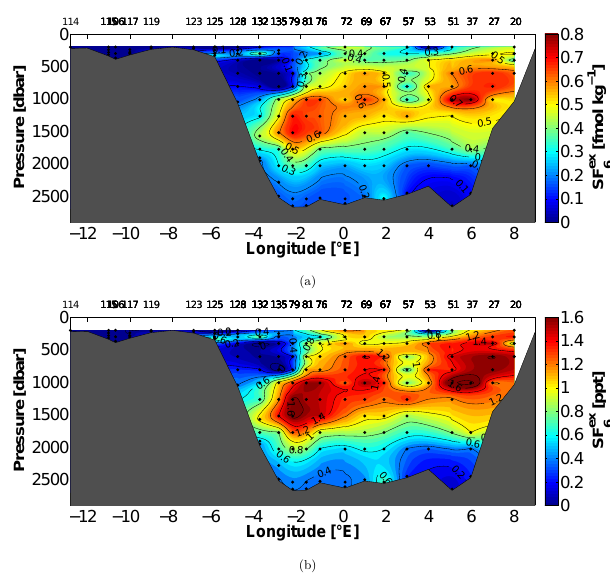
Figure 1 Figure 9. Distribution of SF 6 excess (a) concentrations in fmolkg − 1 and (b) partial pressures in ppt. The upper 200m and station 15 cannot be calculated due to the atmospheric concentra- tion limit of CFC-12 which inhibits an application of the IG-TTD.